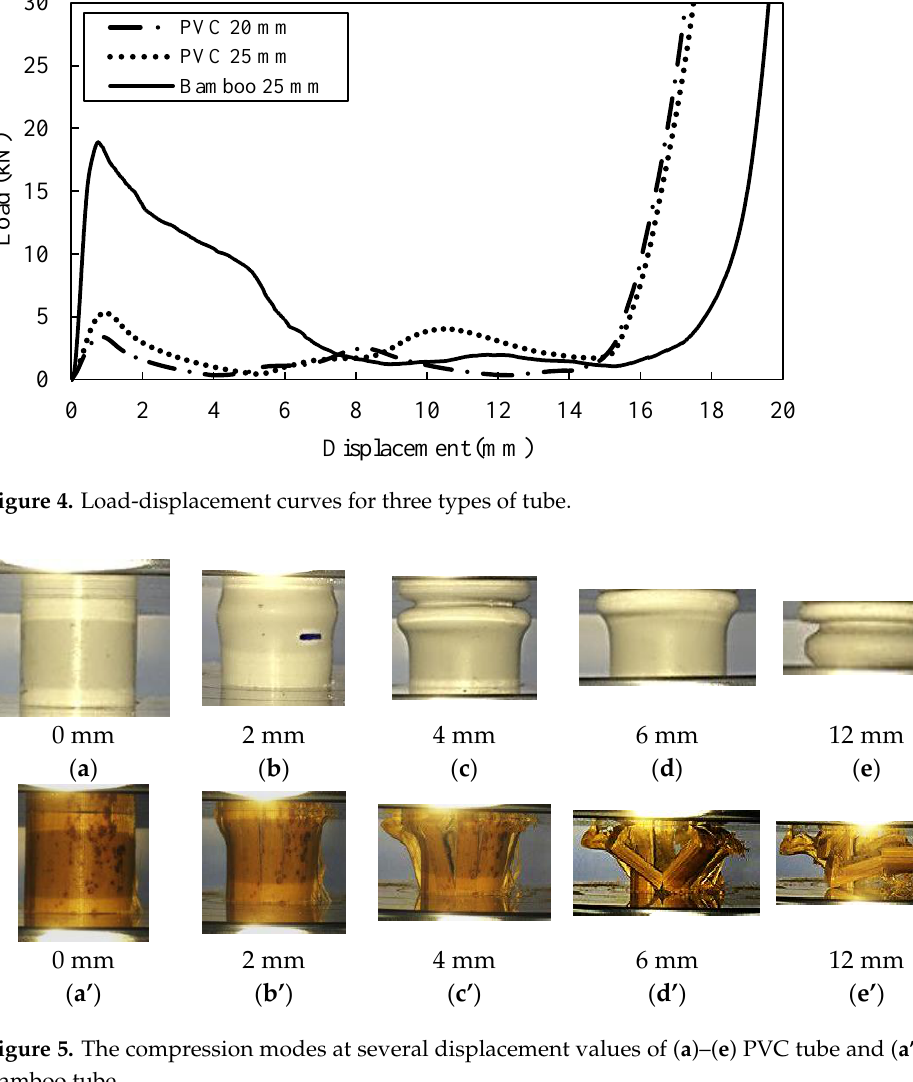
Figure 5. The compression modes at several displacement values of ( a )–( e ) PVC tube and ( a’ )–( e’ ) Bamboo tube.